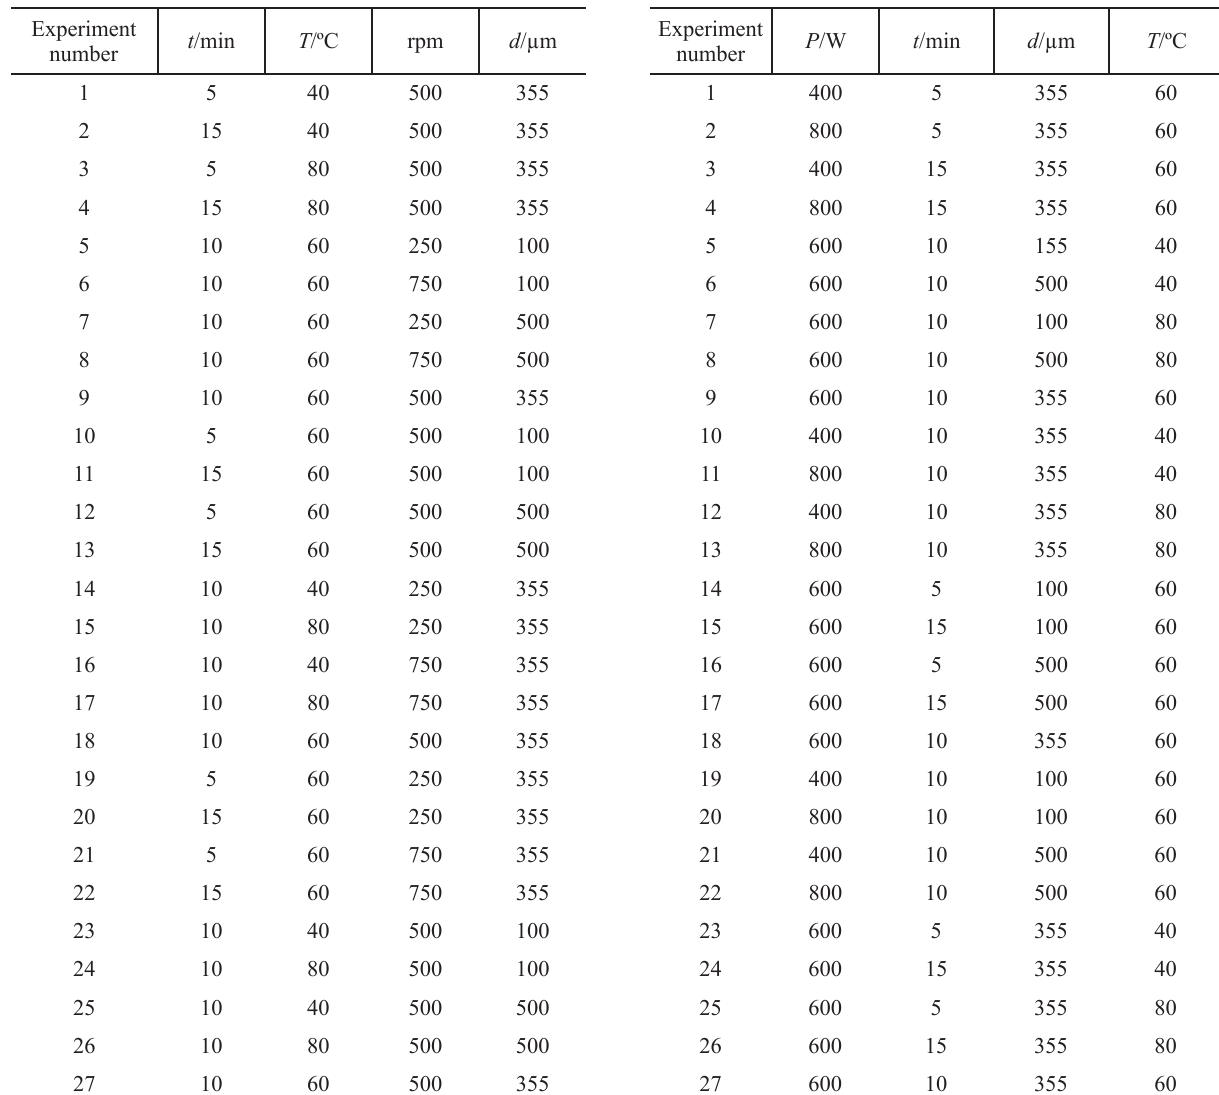
Table 2 – Experimental conditions for microwave-assisted and microwave-ultrasound-assisted